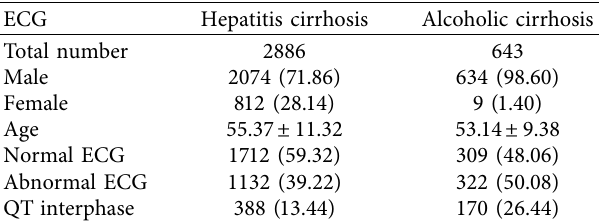
Table 2: Abnormal electrocardiogram and its composition pro- portion of patients with cirrhosis in two groups [cases